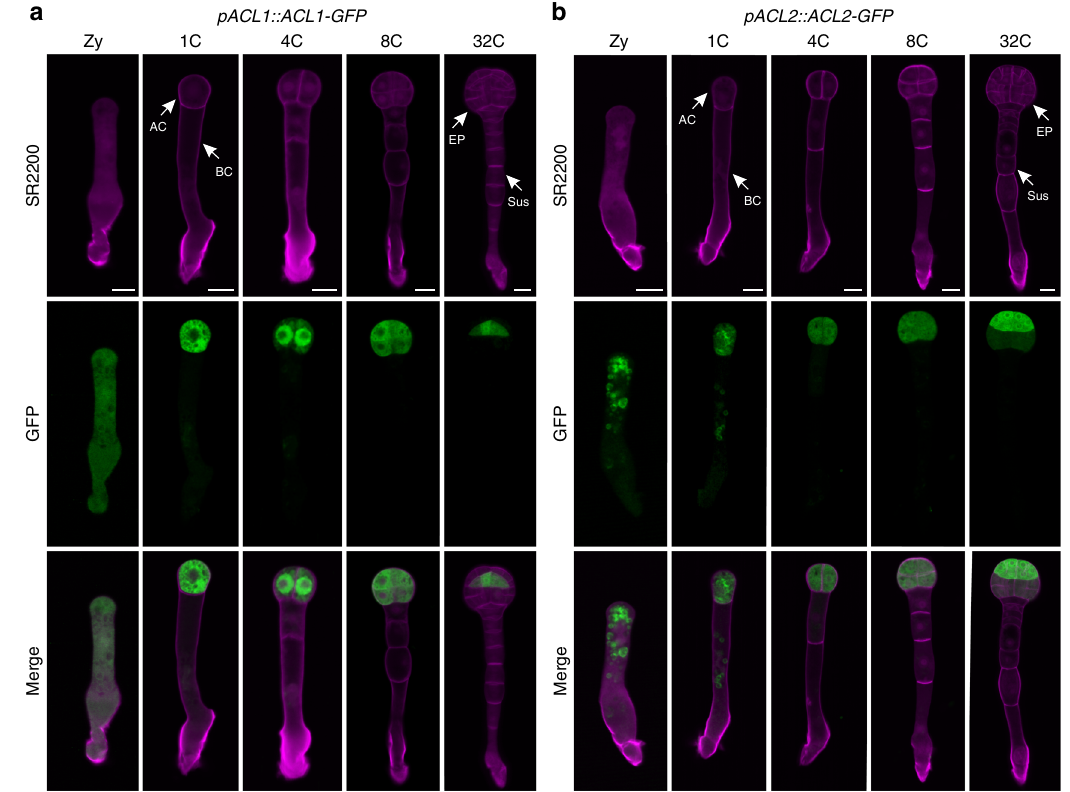
Fig. 4 Expression pattern of selected apical cell lineage-maintained genes validates the transcriptomic analysis. a , b Spatio-temporal expression of ACL1 ( a ) and ACL2 ( b ) in early embryogenesis. Zy zygote, 1C 1-cell embryo, 4C 4-cell embryo, 8C 8-cell embryo, 32C 32-cell embryo, AC apical cell, BC basal cell, EP embryo proper, Sus suspensor. Bar = 10 μ